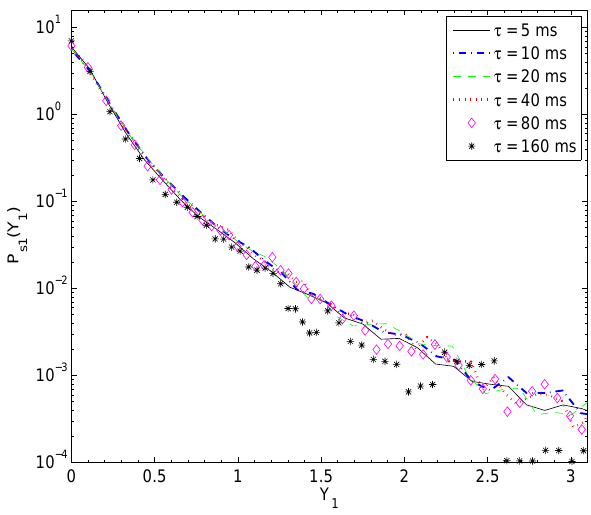
Fig. 8. Mapping of the PDF at the time scale τ = 160ms using the scaling exponent of Regime 1. Comparison with the same mapping for the PDFs at the time scales of Regime 1 shows that the PDF at 160ms does not collapse to the scaling function of Regime